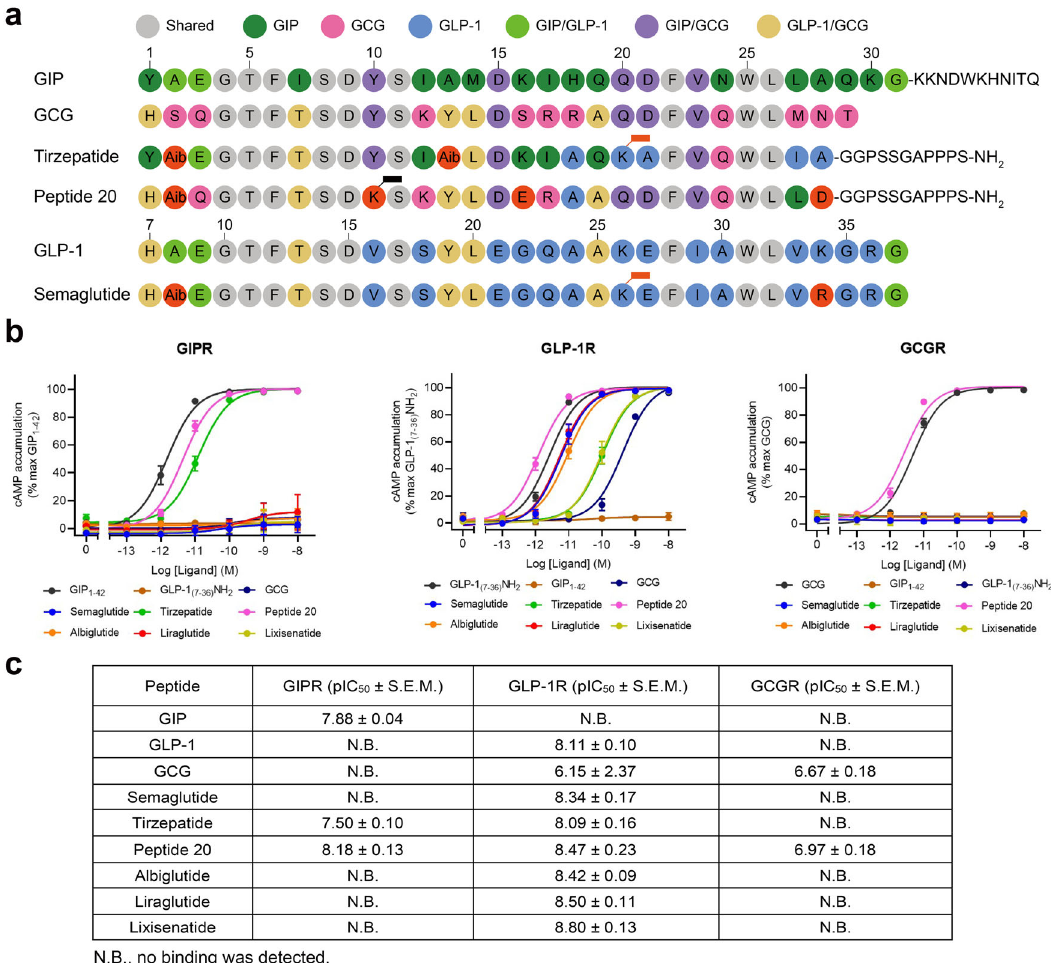
Fig. 7 Structure-basis of receptor selectivity demonstrated by tirzepatide, peptide 20 and GLP-1 analogs. a Amino acid sequences of endogenous agonists, multi-targeting agonists and approved GLP-1 analogs including semaglutide. Residues are colored according to sequence conservation among GIP, GLP-1 and GCG. Aib, aminoisobutyric acid. Semaglutide and tirzepatide are conjugated by a C20 fatty diacid moiety via a linker connected to the lysine residue at position 20, while peptide 20 is covalently attached by a 16-carbon acyl chain (palmitoyl; 16:0) via a γ -carboxylate spacer at K10 P . b Receptor signaling pro fi les of endogenous agonists, multi-targeting agonists and approved drug GLP-1 analogs including semaglutide. Data shown are means ± S.E.M. of four independent experiments ( n = 4) performed in quadruplicate. Source data are provided as a Source Data fi le. c Receptor binding pro fi les of endogenous agonists, multi-targeting agonists and approved GLP-1 analogs. Data shown are means ± S.E.M. of three independent experiments ( n = 3) performed in